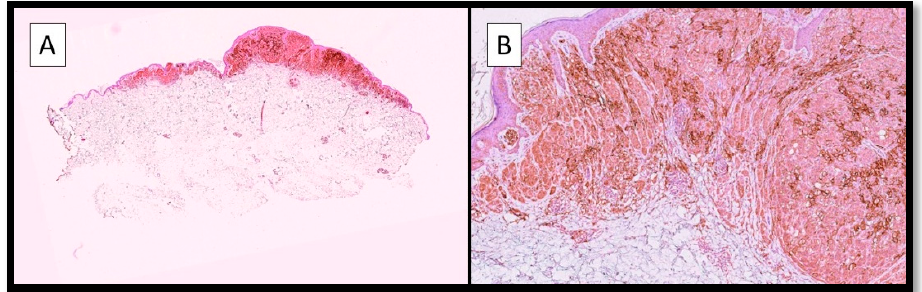
Figure 2. ( A ) Photomicrograph showing an example of immunostaining for TIM-3 in a malignant melanoma specimen. Note the broad positivity of the brown signal at the level of both the neoplastic cells and the TME (Immunostaining for TIM-3, Original Magnification 4 × ). ( B ) Immunohistochemical preparation for TIM-3: note, in more detail, the strong and widespread cytoplasmic positivity of melanoma cells for TIM-3, as well as the presence of positive cells in the TME. Although no data is available in the literature yet, and our data have not yet been published, this expression pattern fits well with the concept of ‘pleiotropism’ specific to TIM-3 (Immunostaining for TIM-3, Original Magnification 10 ×